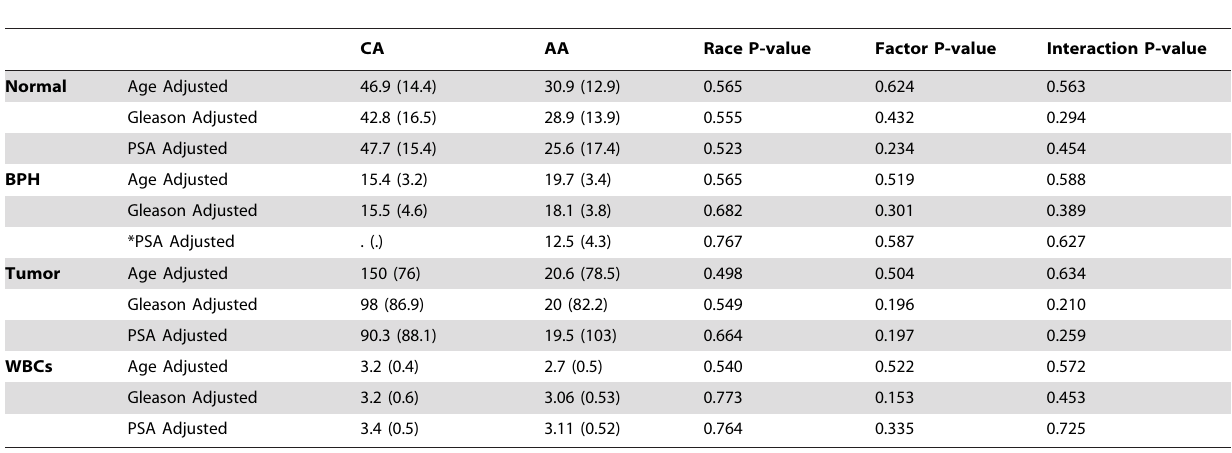
Table 7. Comparison of mtDNA in normal, tumor, BPH, and WBCs between race after adjustment with age, Gleason, and PSA.